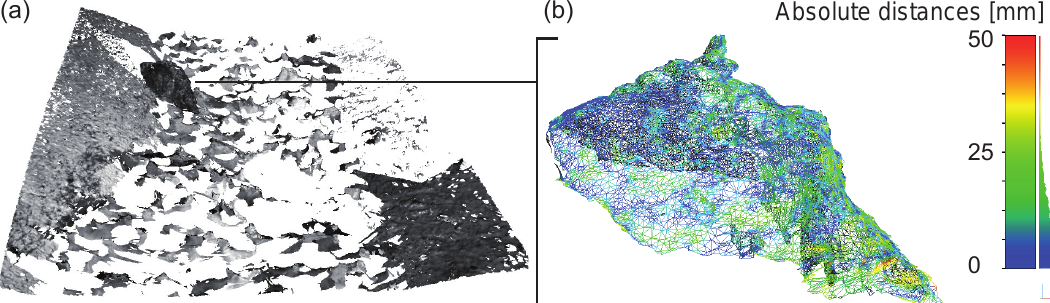
Figure 2. (a) Oblique view of the TLS-derived DSM of the test site highlights the patchy coverage of the penitentes obtained by this method. (b) Absolute differences between DSMs of the sample boulder produced using TLS and